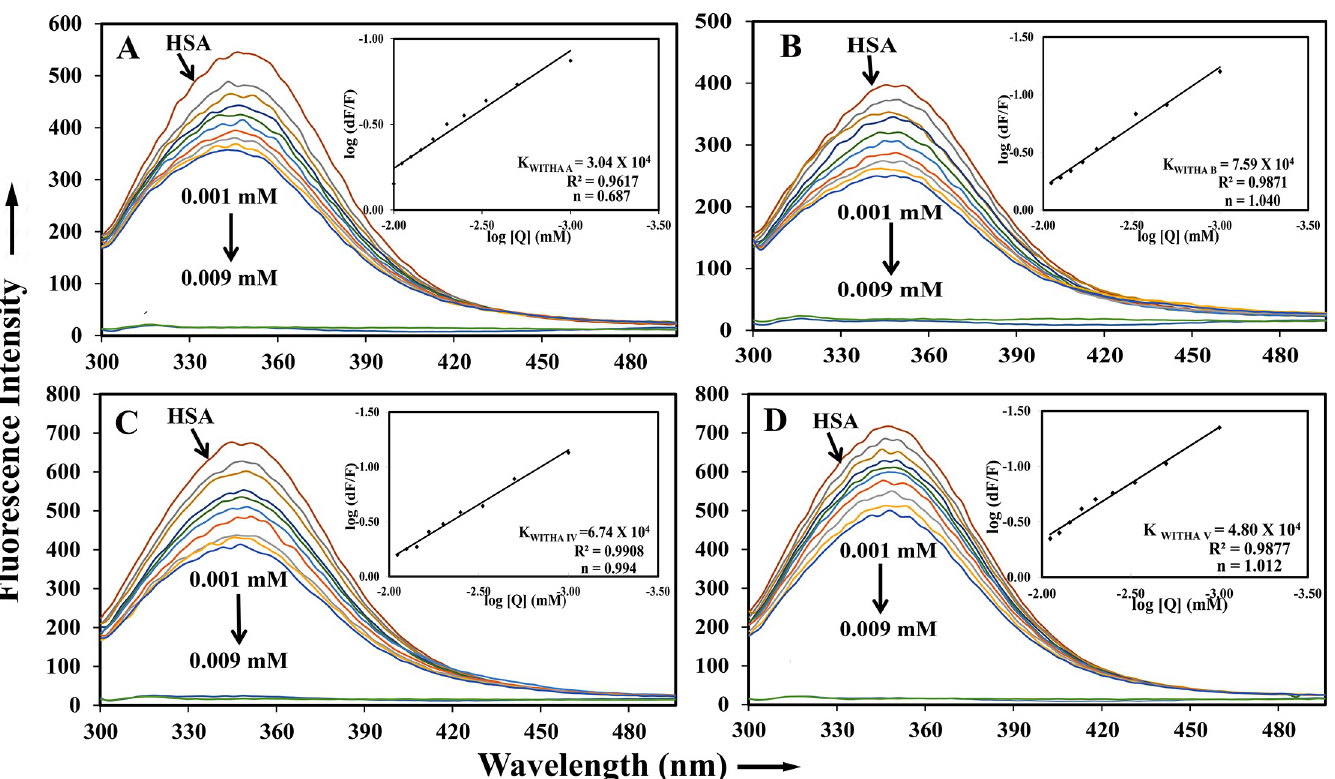
Fig 2. Fluorescence spectroscopic studies of HSA with withanolide and withanoside molecules, indicating the interaction of the drug with plasma protein. The association constant ( K S ) and free energy change along with stern-volmer plots showing fluorescence quenching constant (kq) and plot of Fo/F against [Q] at λ ex = 285 nm and λ em = 360 nm for (A) withanolide A, (B) withanolide B, (C) withanoside IV and (D) withanoside V.